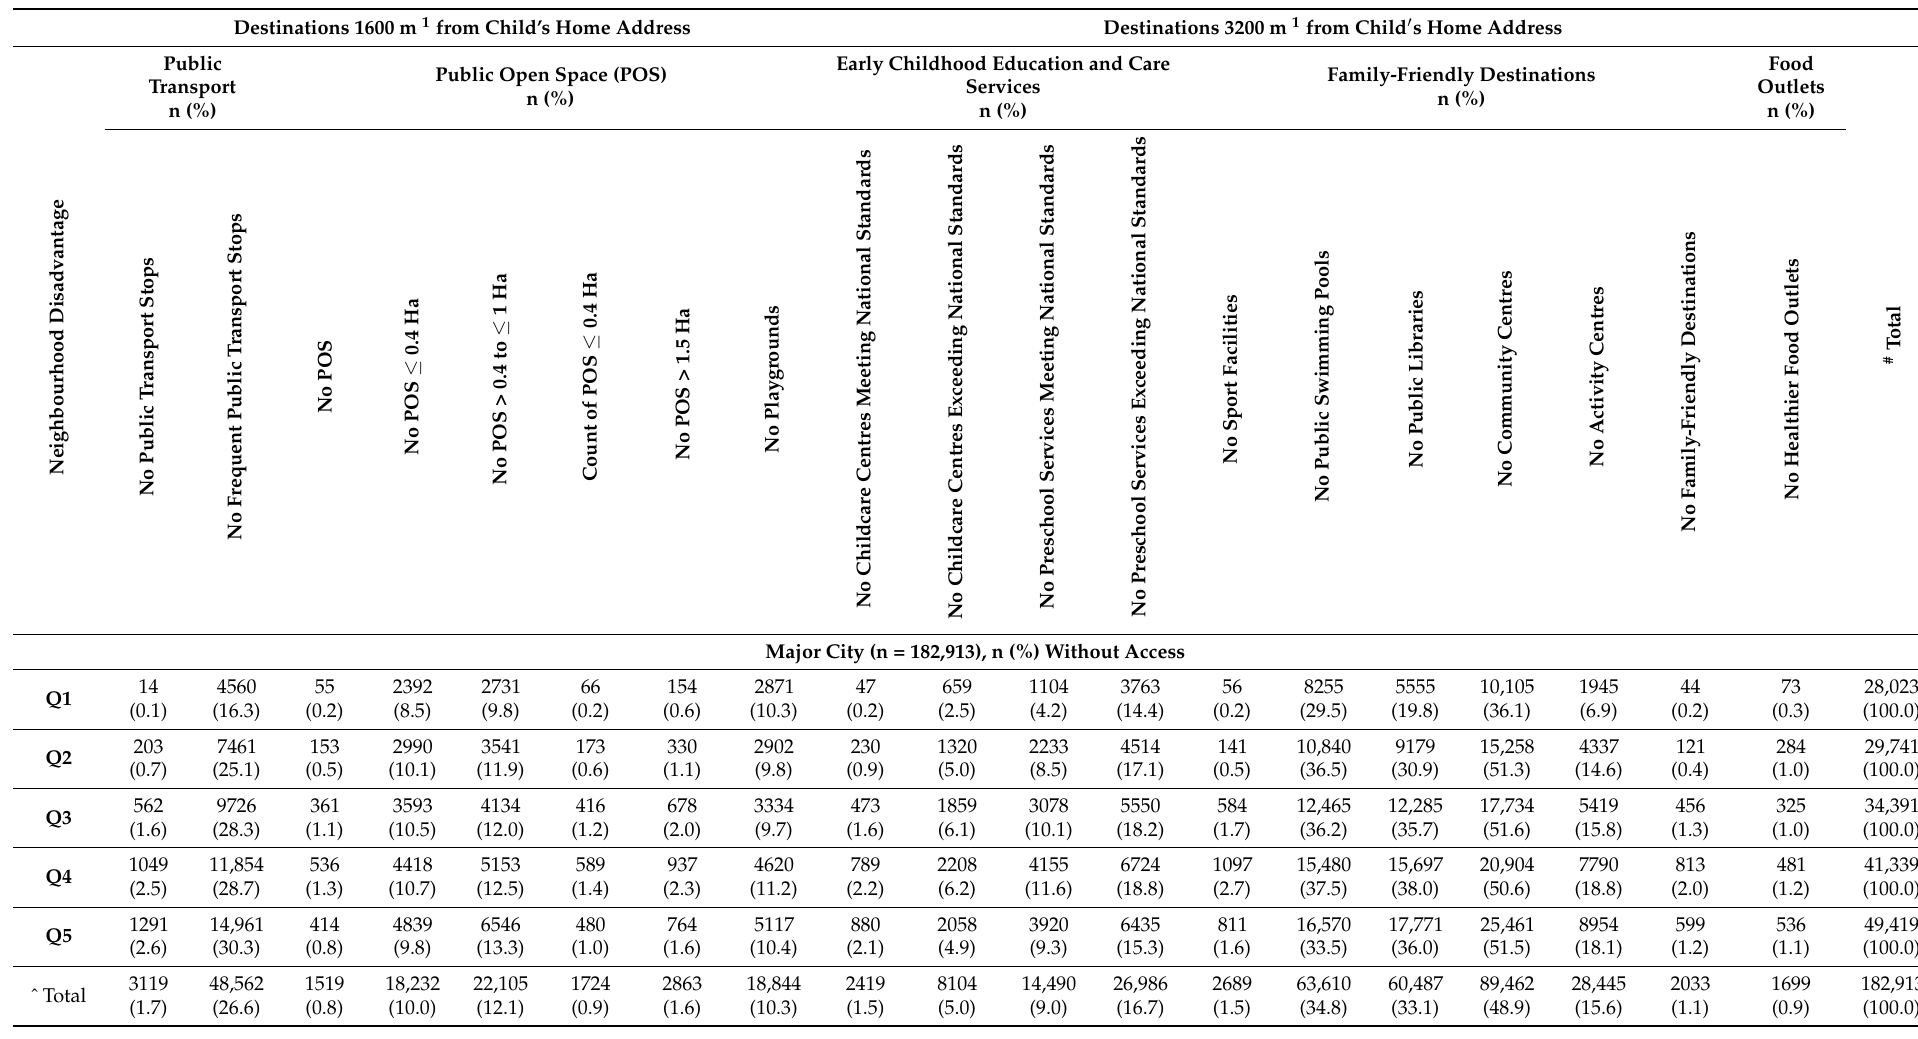
Table 3. Proportion of children in Australia’s major and regional cities with no (zero) local destinations/services by neighbourhood